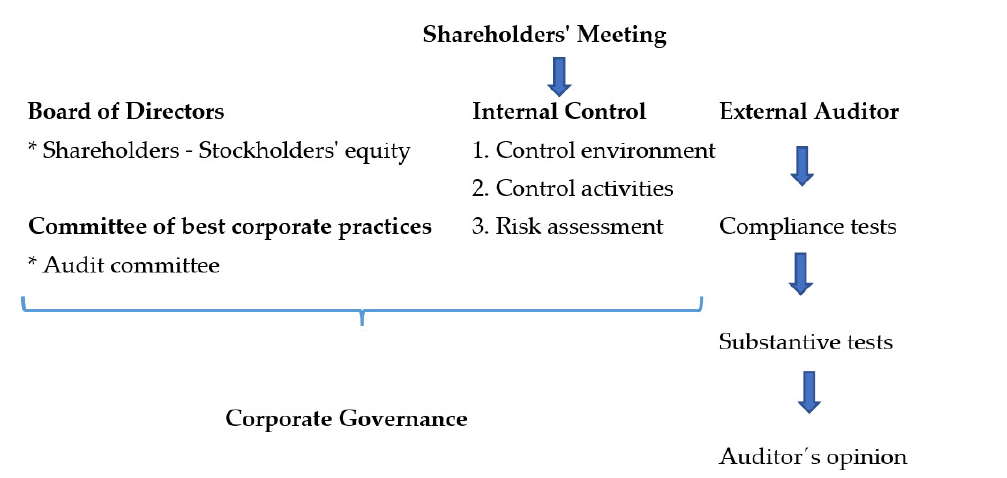
Figure 1. Corporate Governance